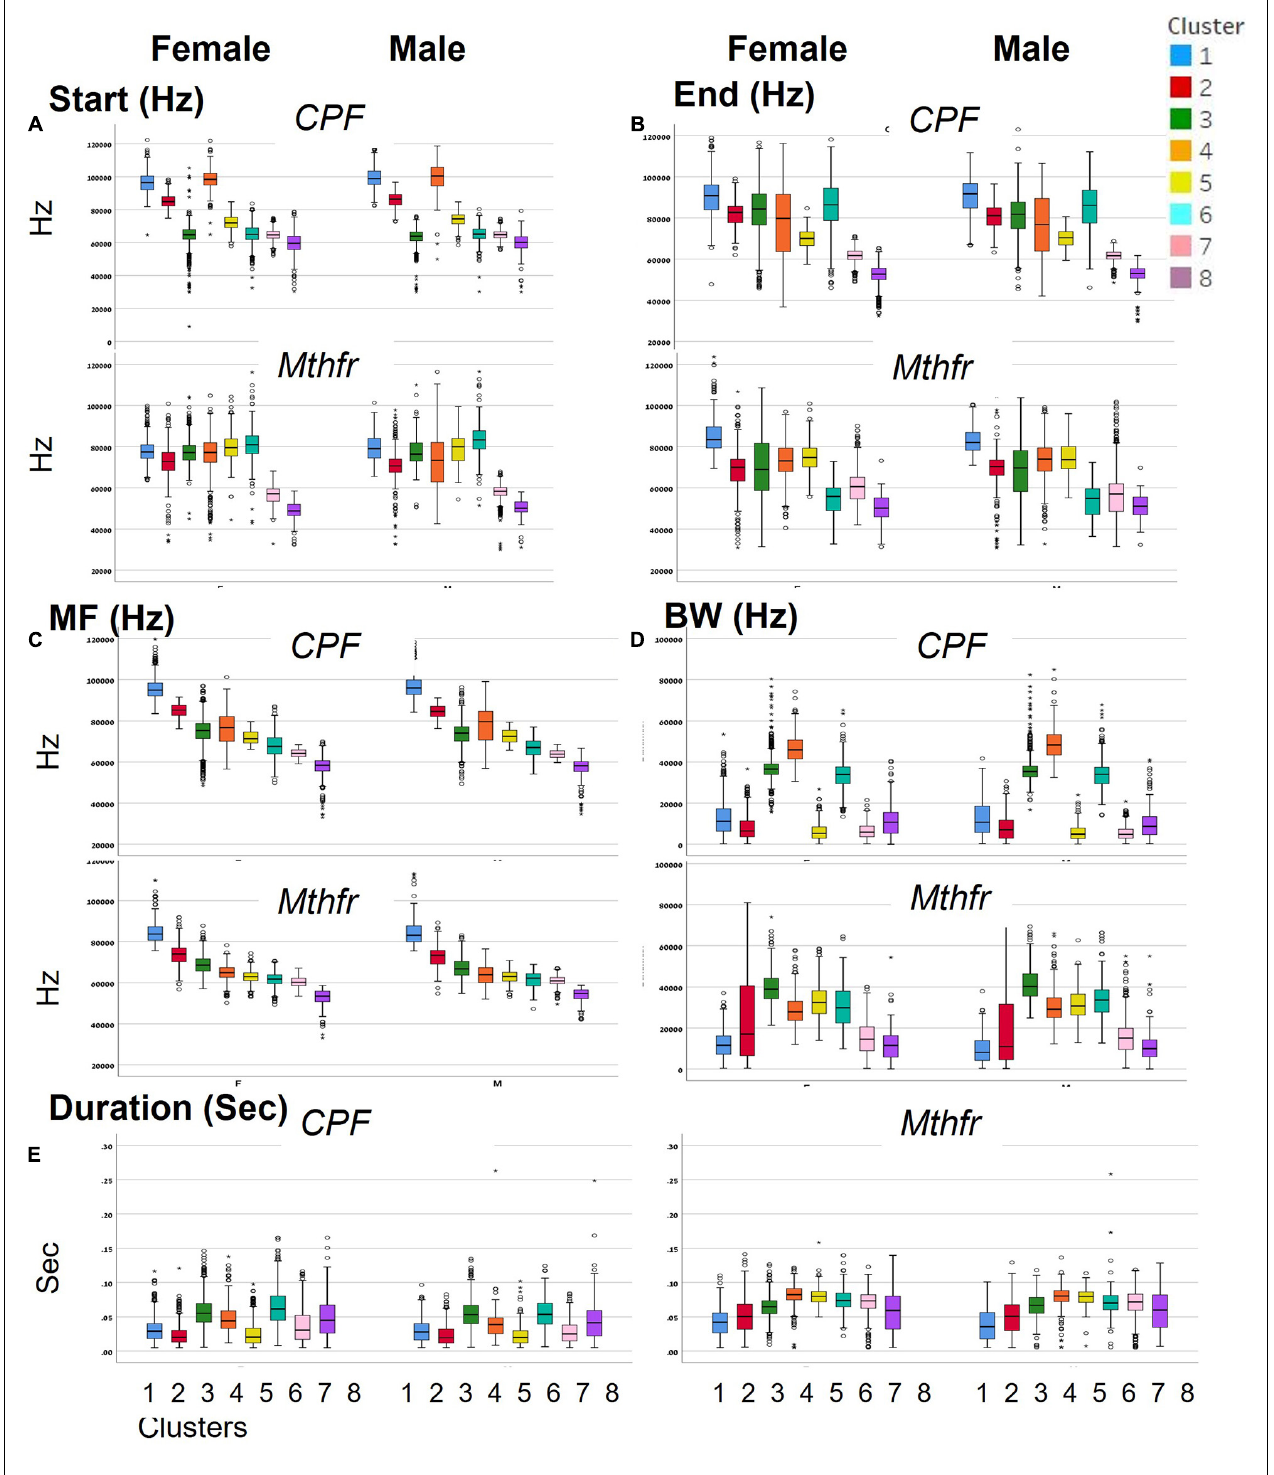
FIGURE 3 | Distinct spectral and temporal characteristics of the syllable clusters. Spectral and temporal characteristics of the syllables in each of the clusters for female and male of CPF and Mthfr models: (A) start frequency, (B) end frequency, (C) mean frequency, (D) bandwidth, and (E) duration. Median, confidence interval (95 and 5%) and outliers are presented. Note that each ASD model has a unique cluster distribution; the number and color code for Mthfr model do not overlap with the same characteristics in the CPF model.